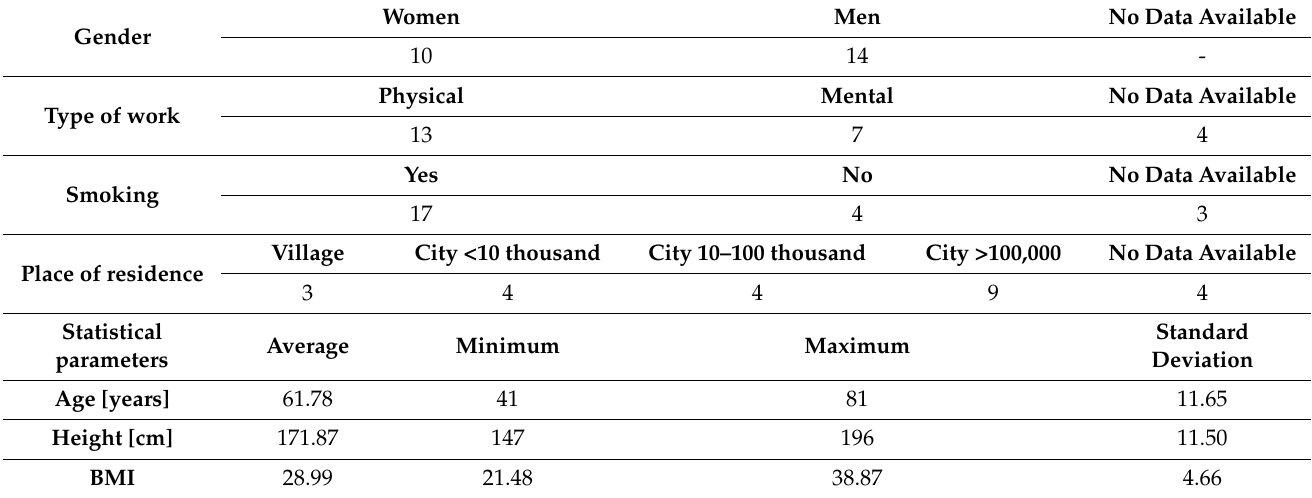
Table 1. Characteristics of the study